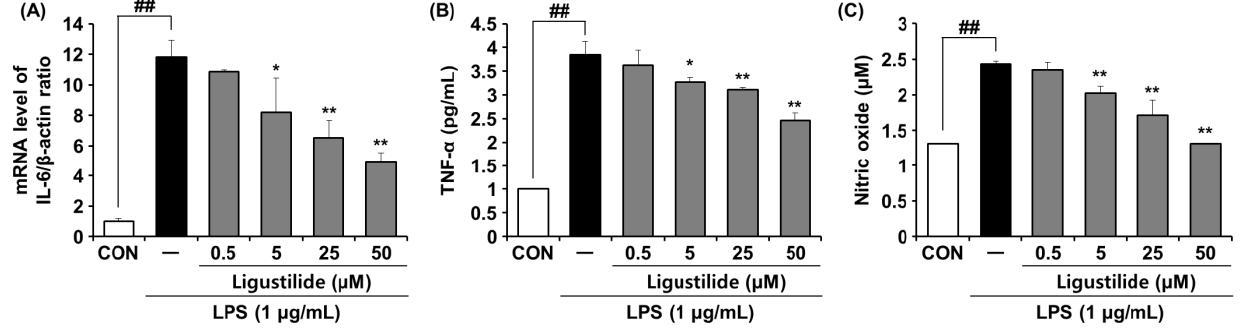
Figure 6. Effects of ligustilide on the mRNA expression of IL-6 and pro-inflammatory mediator pro- duction in LPS-induced RAW264.7 cells. ( A ) IL-6 was determined by RT-PCR. ( B ) TNF- α and ( C ) NO production were measured by using ELISA. Statistical significance was assessed by one-way ANOVA followed by Tukey’s test. * p < 0.05, ** p < 0.01 and ## p < 0.01 compared with the untreated